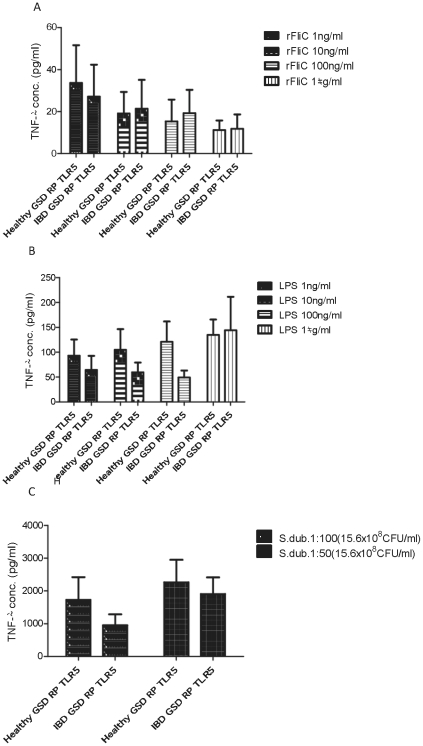
TNFα secretion in whole blood stimulation assays with flagellin, LPS or heat-inactivated Salmonella dublin in healthy GSDs and those with IBD carrying the risk-protective TLR5 haplotype.Whole blood was diluted with twice the volume of RPMI and stimulated with flagellin, LPS or heat-inactivated Salmonella dublin at different concentrations for 24 hours before production of TNFα was analysed by an ELISA. The results displayed are the mean values obtained from five dogs, with error bars illustrating standard error of the mean. There was no significant difference in TNFα response to flagellin, LPS or Salmonella dublin between healthy GSDs and those with IBD all carrying the risk-protective TLR5 haplotype at any of the concentrations tested (p>0.05).